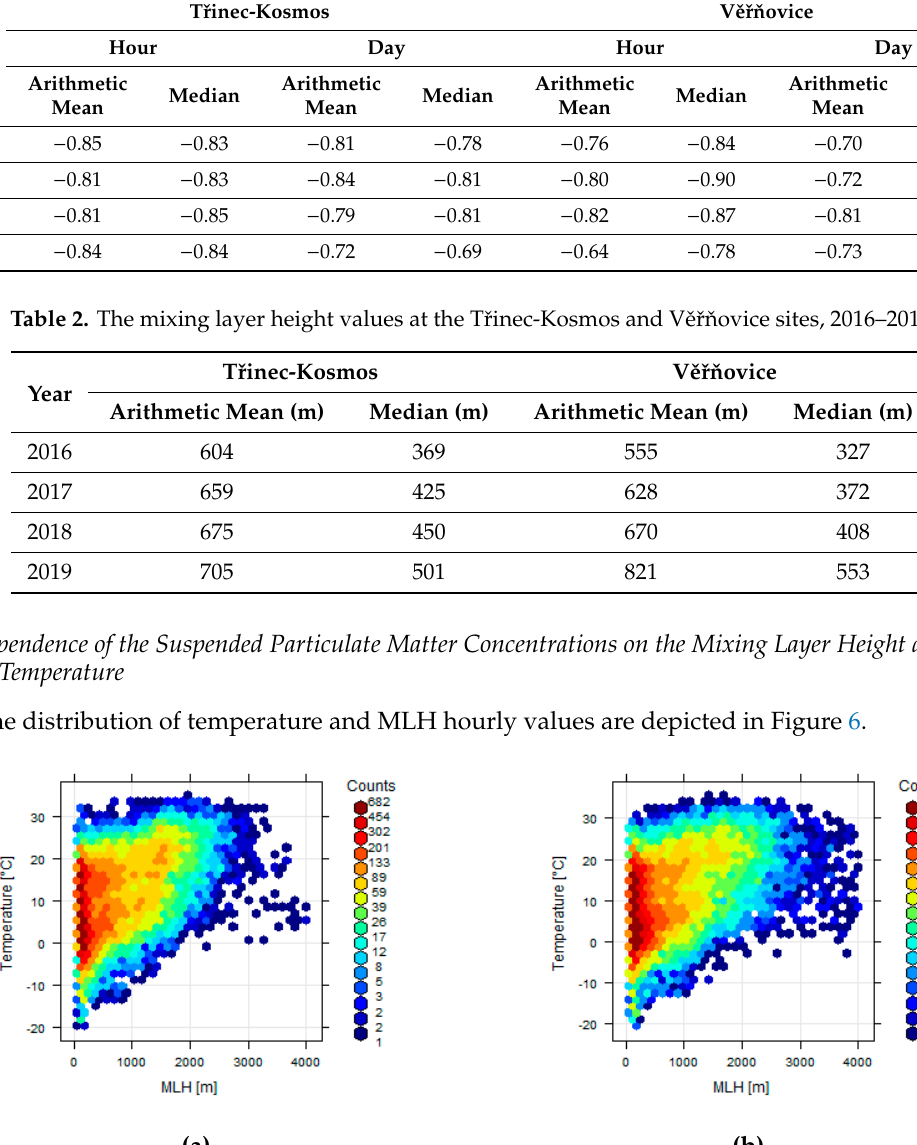
Table 1. Correlation coefficients of PM 10 concentration dependences on MLH and the mixing layer height values at the T ř inec-Kosmos and V ěřň ovice sites, 2016–2019.